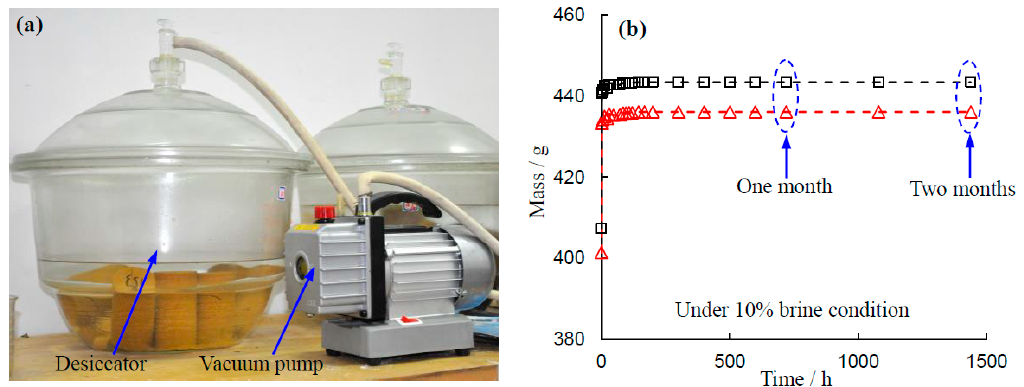
Figure 2. Saturation process under saline condition. ( a ) Desiccator and vacuum pump used for brine saturation; and ( b ) mass change of two sandstone specimens against time.